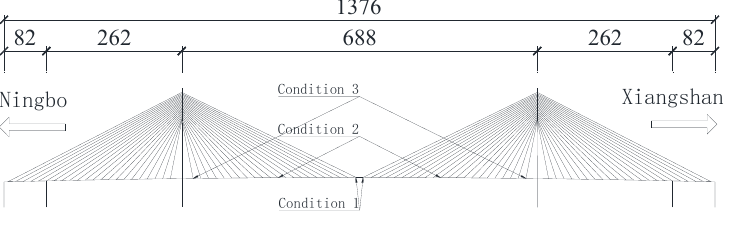
Figure 16. Schematic diagram of cable breakage position (m). Table 5. Flutter critical wind speed of Xiangshan Harbor Bridge at different cable breakage location.